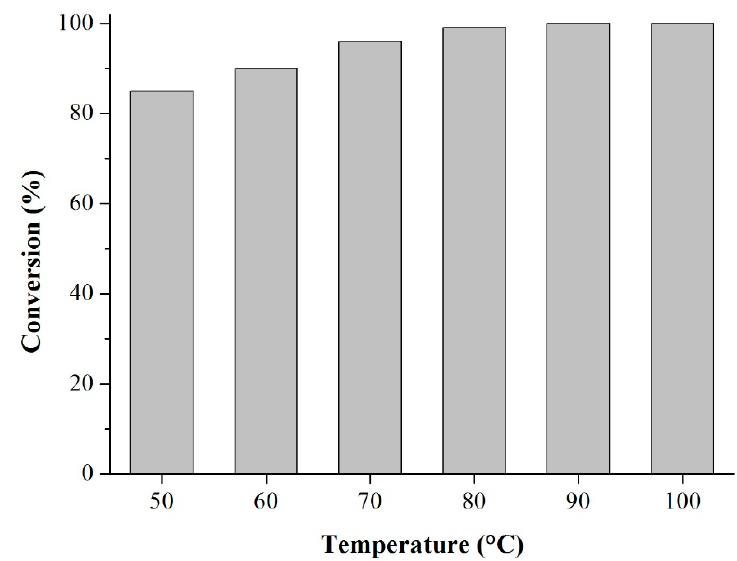
Figure 7. Effect of acetylation reaction temperature. Reaction conditions: EugOH: AA molar ratio (1:5), reaction time 40 minutes and 2% catalyst.